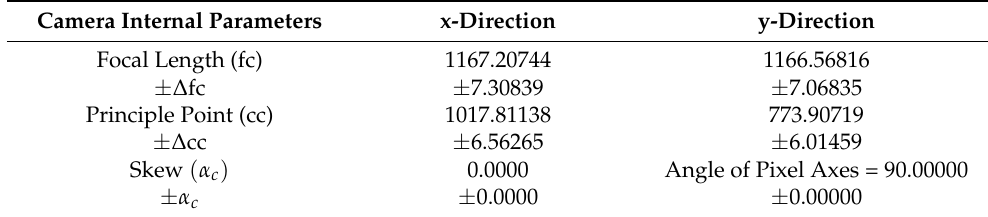
Table 1. Camera internal parameters table.